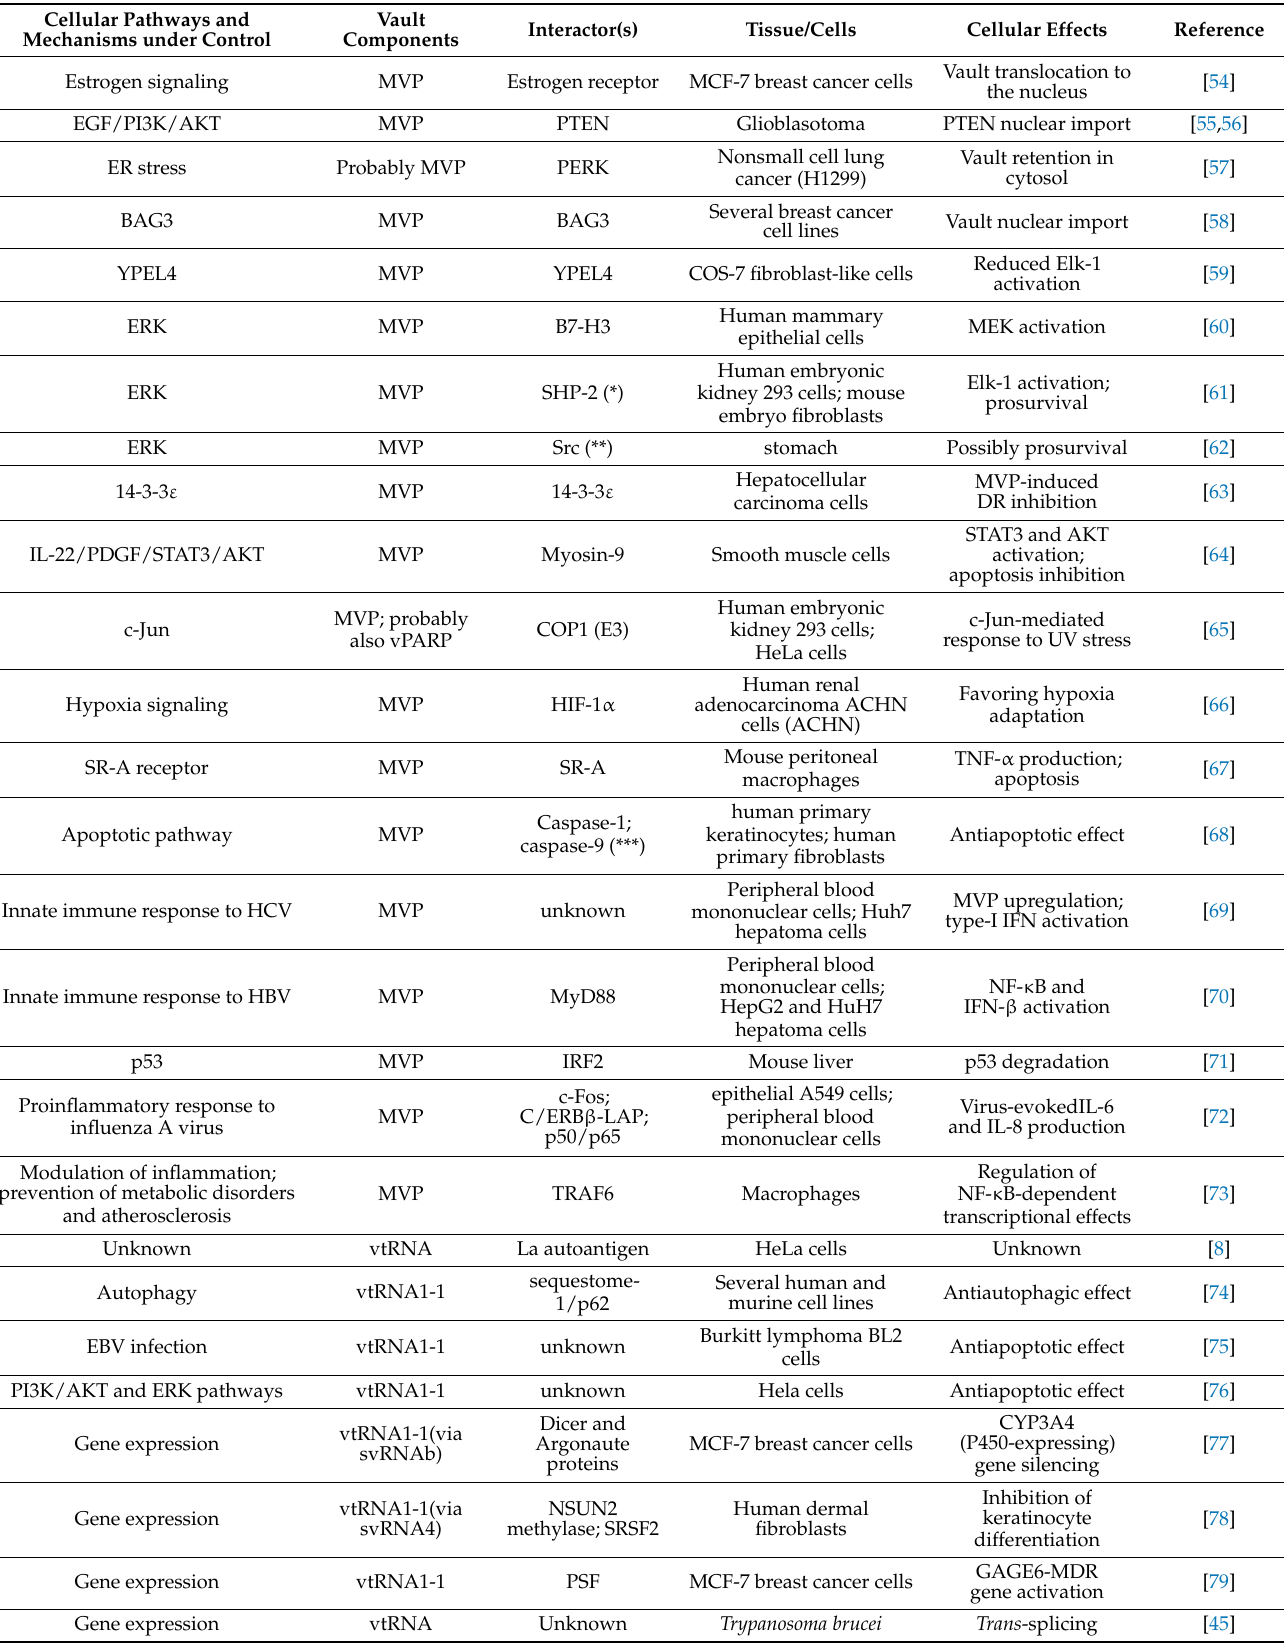
Table 1. The involvement of the vault nanoparticle in signaling